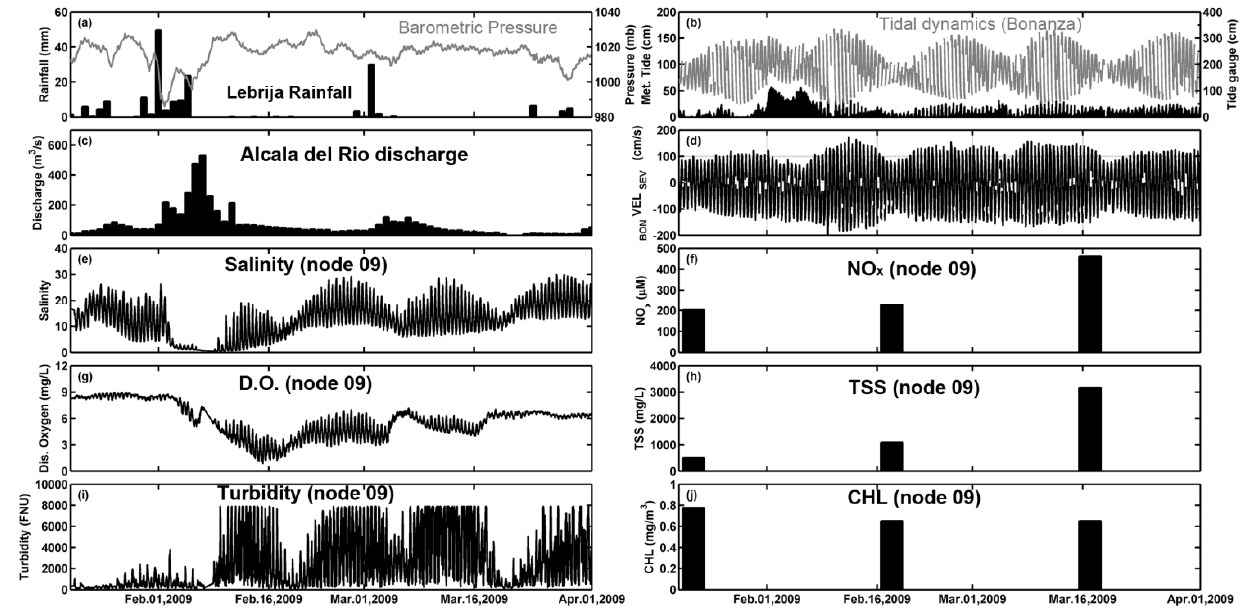
Figure 9. ( a ) Daily rainfall (black bar) registered by the meteorological station located in Lebrija and atmospheric pressure (grey line) recorded at the meteorological node; ( b ) Meteorological gauge (black bar) and tide gauge (grey line) measured at Bonanza; ( c ) Daily average river discharge from the Alcalá del Río dam; ( d ) Water current velocity measured by the hydrodynamic node at 1-m depth (negative, downstream current in the estuary). Real-time remote monitoring data observation at node 09 of salinity ( e ), dissolved , total suspended solids and oxygen ( g ) and turbidity ( i ). Temporal distributions of NO x chlorophyll distribution at node 09 ( f, h and j ,